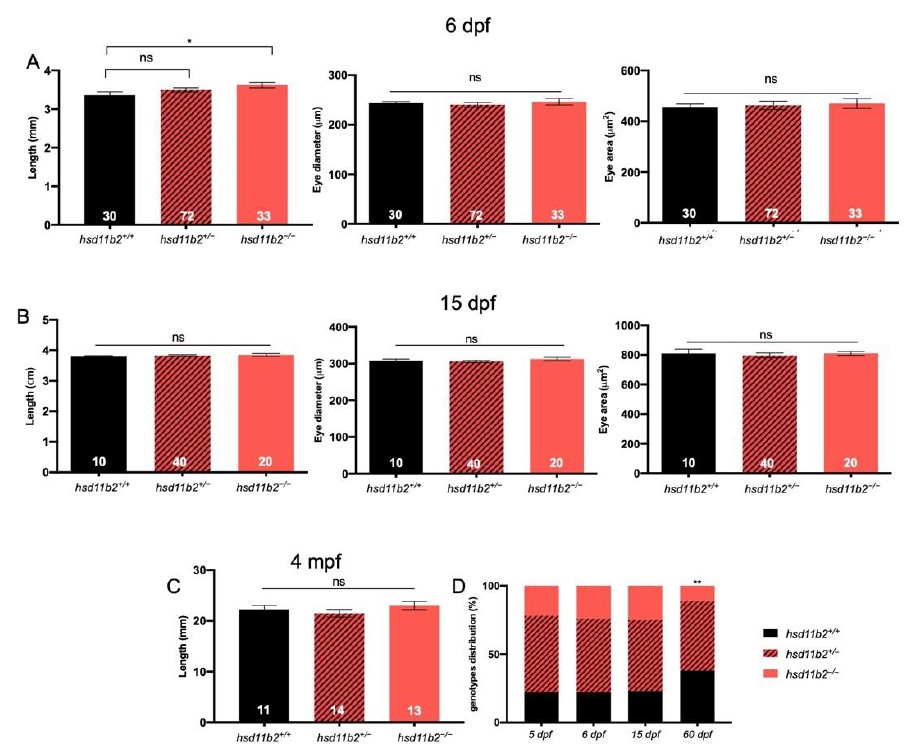
Figure 2. Morphometric analysis of hsd11b2 mutant zebrafish line. ( A ) Measurements of body length, eye diameter and eye area of 6-dpf hsd11b2 +/+ , hsd11b2 +/− and hsd11b2 −/− larvae. ( B ) Measurements of body length, eye diameter and eye area of 15-dpf hsd11b2 +/+ , hsd11b2 +/− and hsd11b2 −/− larvae. ( C ) Measurements of body length of 3-mpf hsd11b2 +/+ , hsd11b2 +/− and hsd11b2 −/− fish. ( D ) Survival of hsd11b2 +/+ , hsd11b2 +/− and hsd11b2 −/− animals at 5, 6, 15 and 60 dpf . Mean ± SEM. significant. Student’s t -test was used to evaluate the morphometric differences and X 2 test was used to evaluate the differences of genotype distribution compared to the expected ratios. * p < 0.05; ** p < 0.01; ns = not